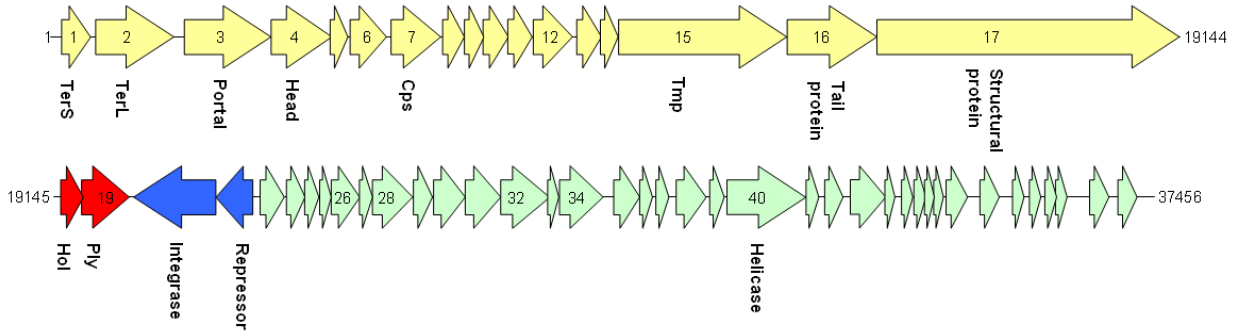
Figure 3. Pulsed-field gel electrophoresis of full length TP21-L genomic DNA